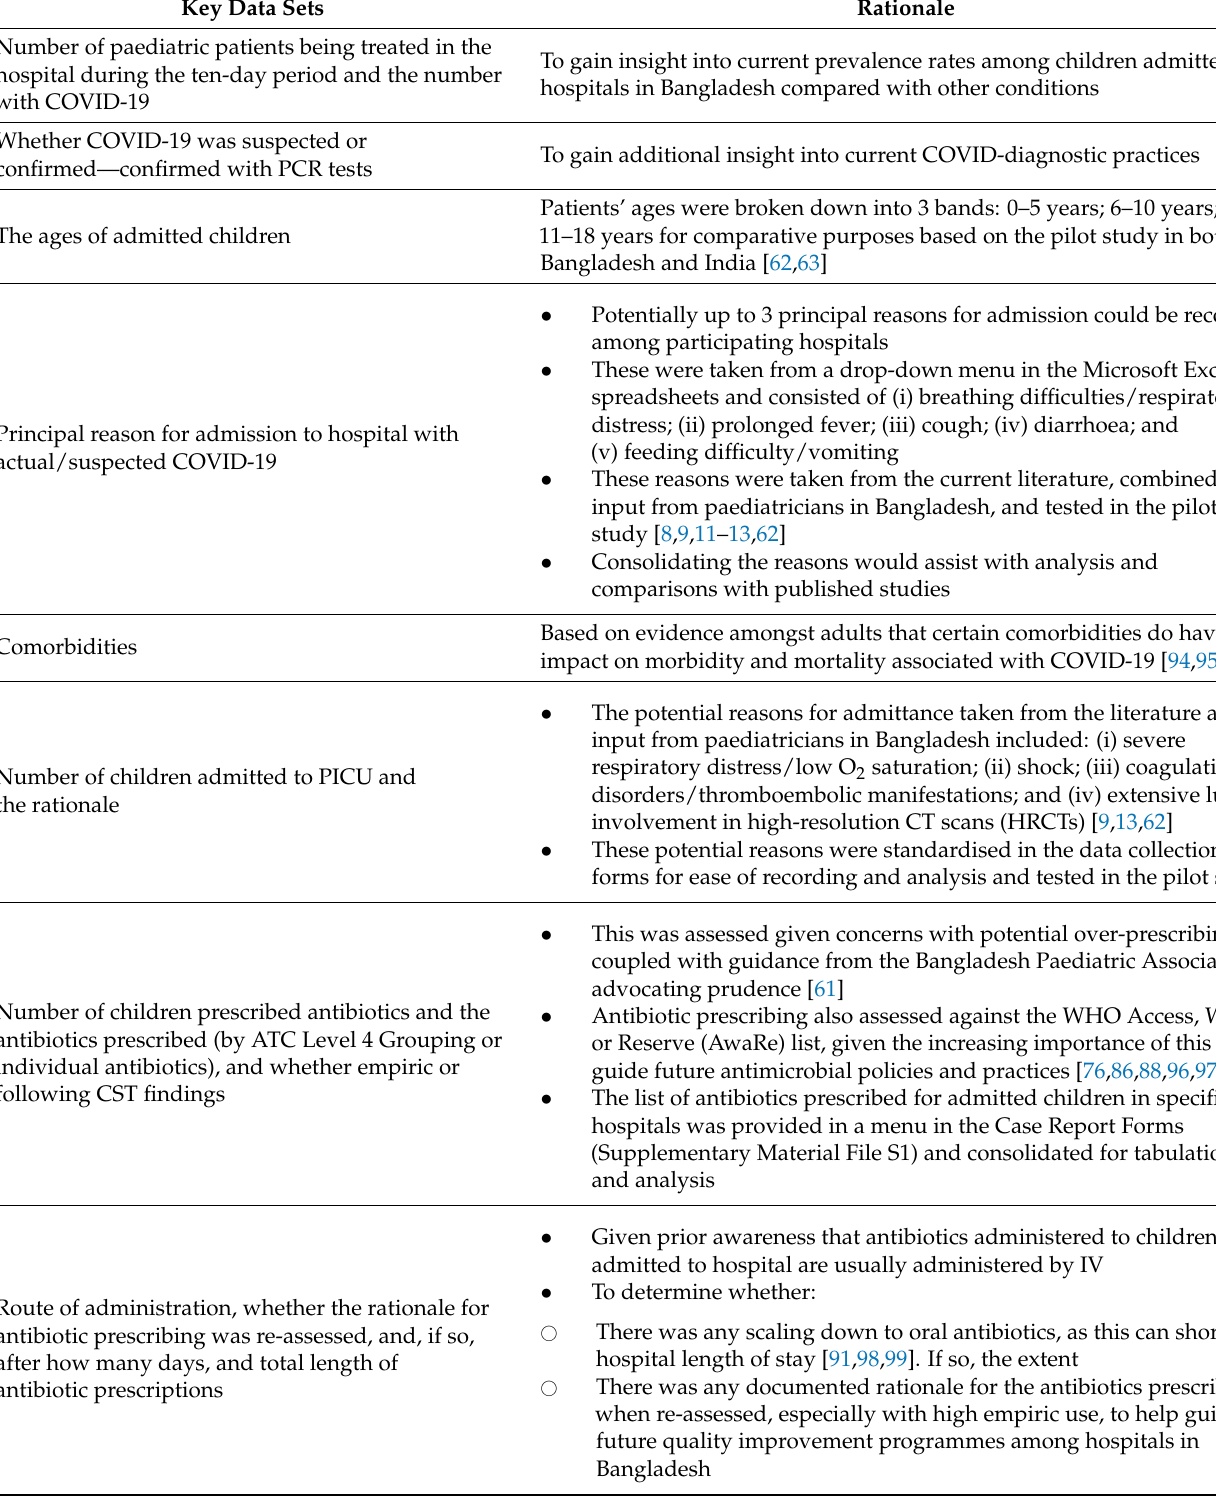
Table 6. Key data sets collected and their